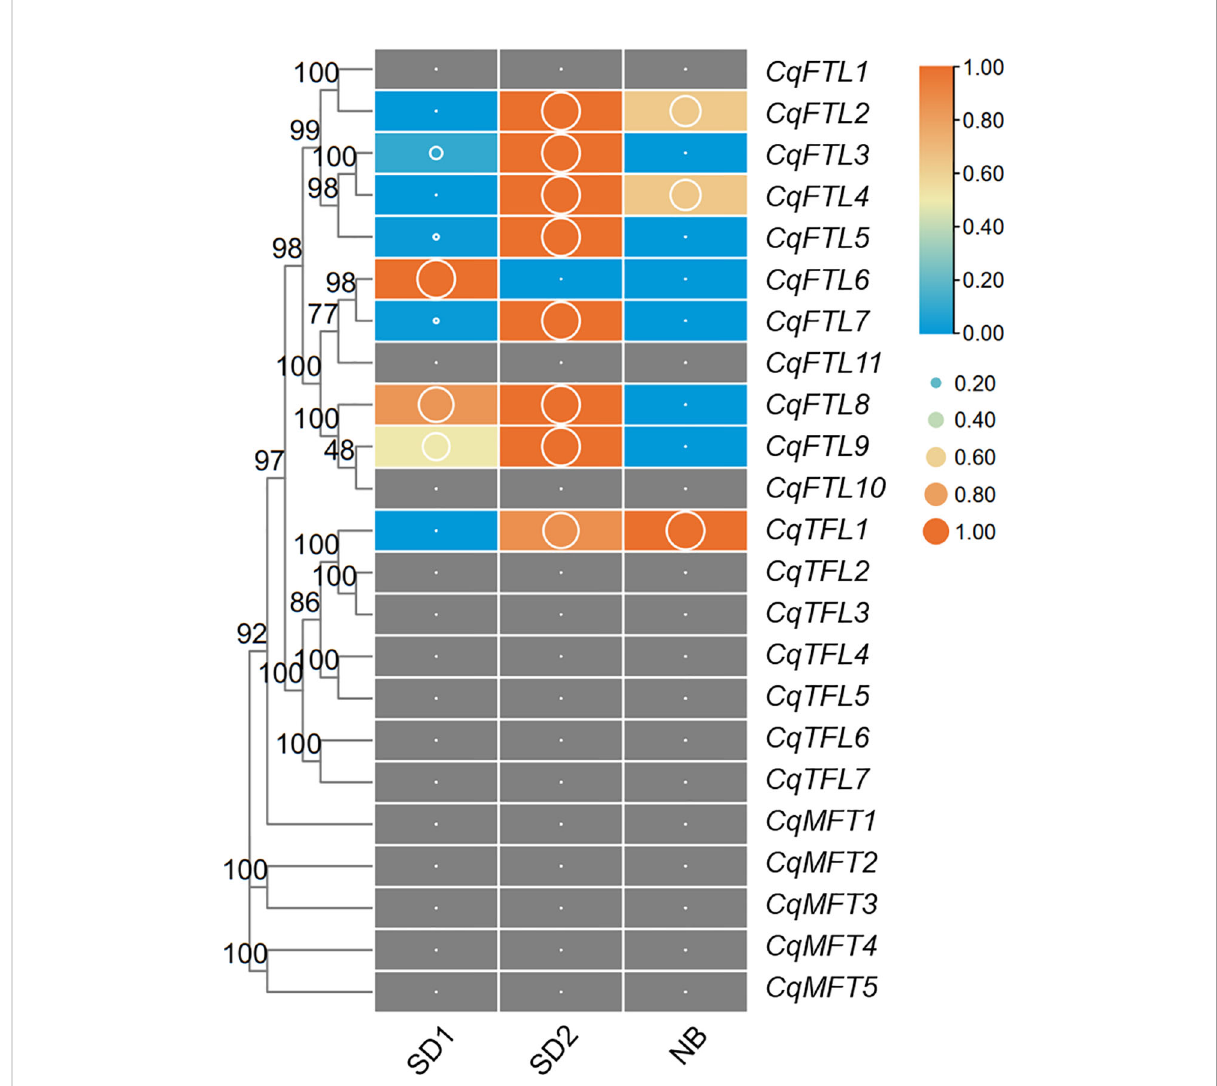
FIGURE 10 Investigation on the transcriptional changes of PEBP s in response to night break. Our previously published transcriptome data was used to. SD1 and SD2 indicate leaf samples collected from 14-day- and 26-day-old plants under short-day conditions. NB indicates the leaf sample of SD2 plants with 2d night-break treatment. Each expression value was generated from three replicates. Orange boxes with larger-size bubbles indicate higher expression levels. Expression values (cutoff=0.1) in various leaf samples of the same gene were normalized to 0 to 1 by